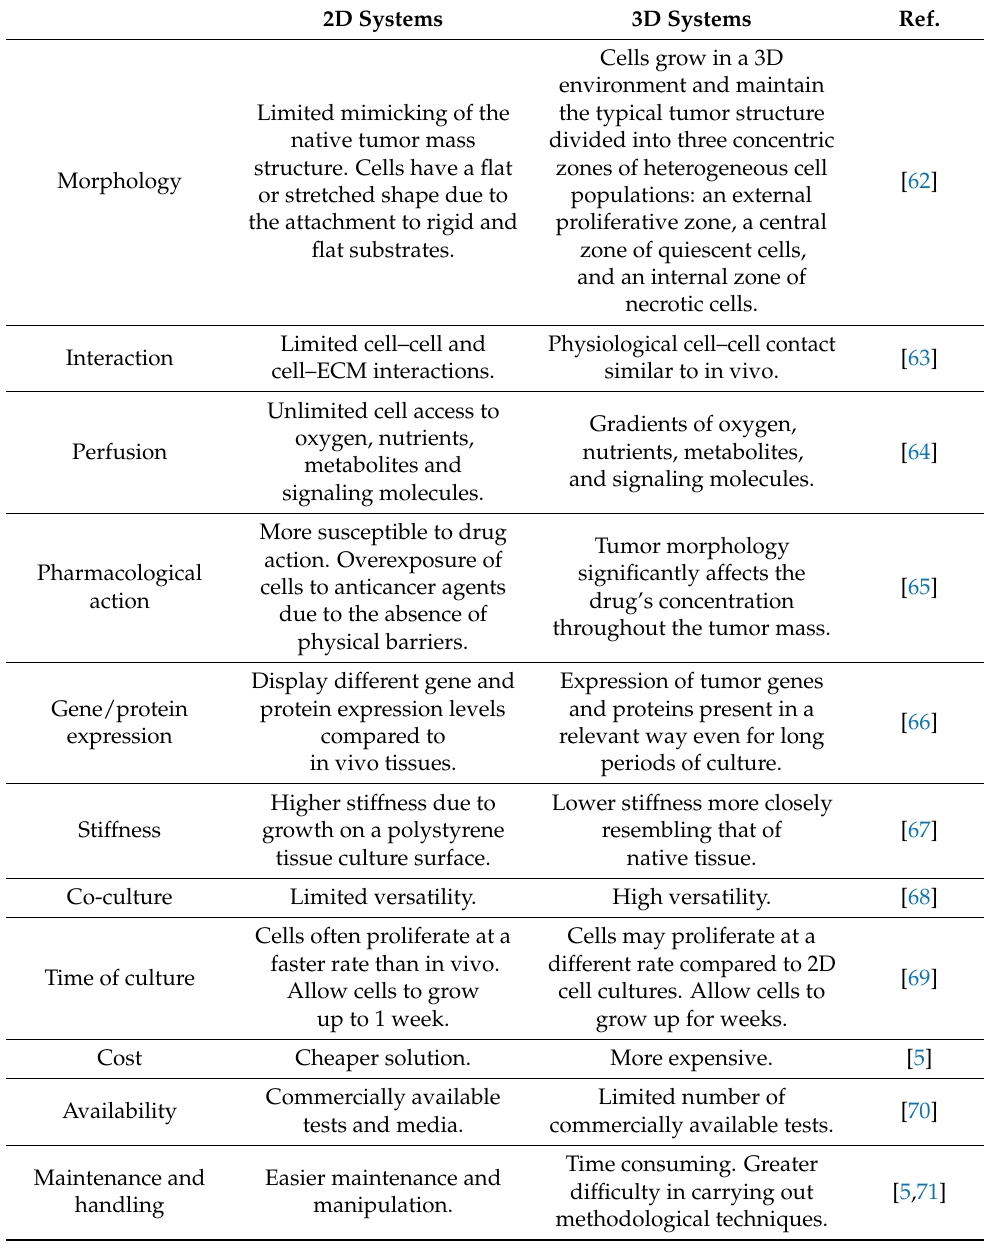
Table 1. Peculiar features of 2D and 3D cell cultures for in vitro